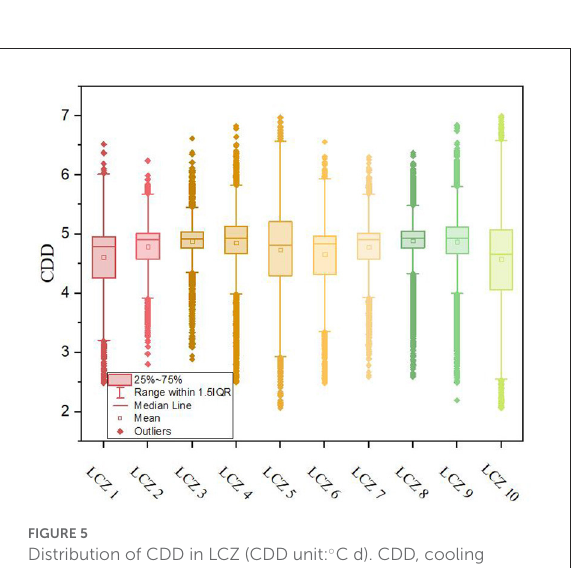
FIGURE5 Distribution of CDD in LCZ (CDD unit: ◦ C d). CDD, cooling degree-days. The results are sampled and counted according to the calculation results associated with the grid of the different LCZ